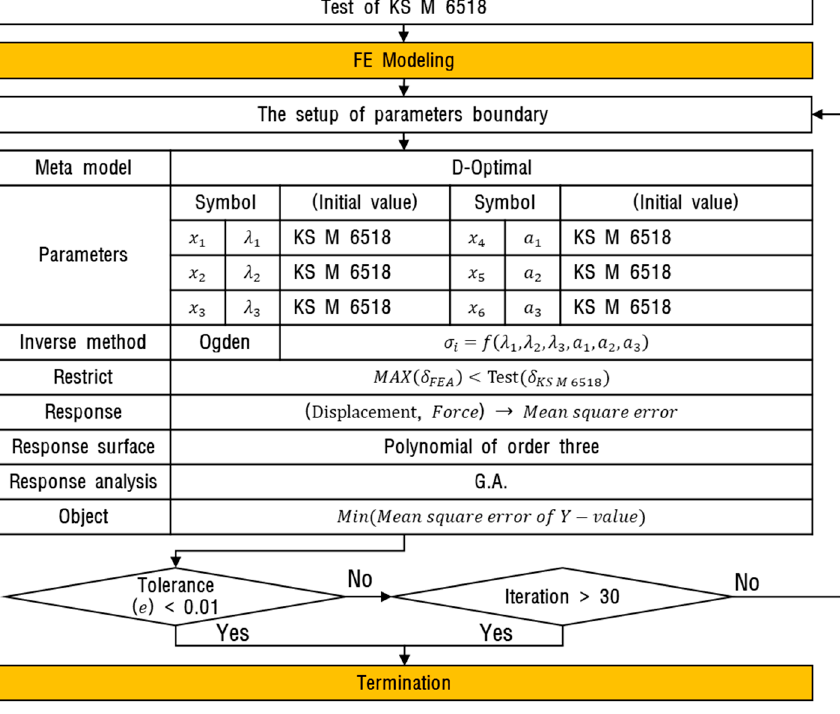
Figure 8. Experimental data expressed as points and FEA results expressed as dotted lines. 3. Grommet Mechanical Properties and Inverse Method 3.1. Bonding Force Test The main indicator of grommet performance is the force that secures the cable position. Figure 9 is a schematic of a hollow shaft grommet to observe the bonding force. The grommet is bonded with the cable by press fitting. Table 3 show the details of specimen.